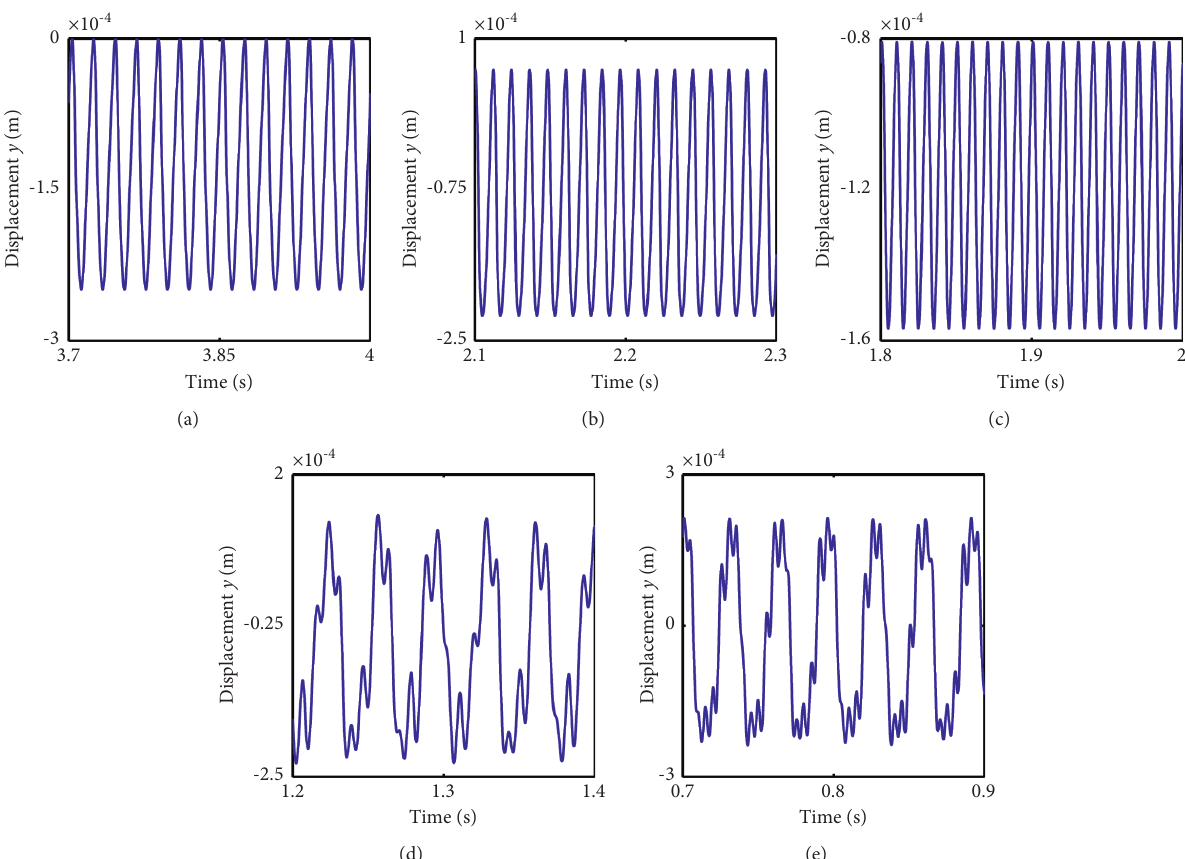
Figure 5: Vibration waveforms of the right journal. (a) ω � 2800r/min, (b) ω � 5000r/min, (c) ω � 6000r/min, (d) ω � 7500 r/min, and (e) ω �